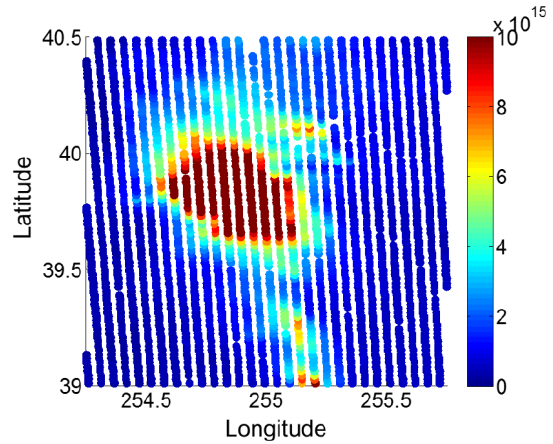
Figure 2. Example of synthetic TEMPO NO 2 column observations over Denver, CO, at 17:00MST on 2 July